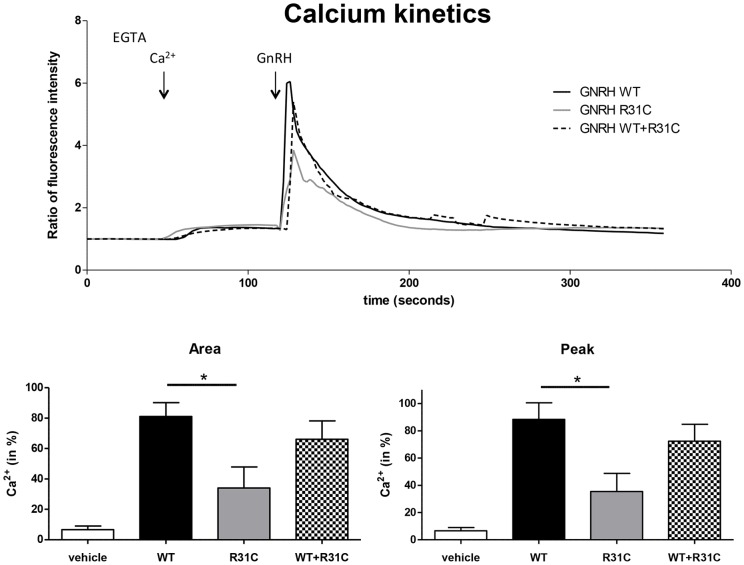
Effect of treatments on intracellular calcium mobilization.Cells were loaded with Fura 2-AM. At the time of the experiment 100 µM EGTA was added 30 sec before addition of 300 µM of CaCl2 (Ca2+) to the medium as indicated, and cells were then stimulated with 10 nM of wild type (WT), mutant (R31C) or equimolar combination (10 nM WT +10 nM R31C) or vehicle for 3 min. In the upper panel, representative curves of single cell recording. Each experiment mean was analysed using One-way ANOVA followed by Tukey's Multiple comparison test. In the lower panels, histograms show the means ± SEM (n = 4) of the response to ligands as calcium peak and as area under the curve (AUC). R31C-induced peak and AUC were significantly lower than WT. Combined treatment by WT+R31C did not induce a different calcium peak and AUC compared to WT alone. Representative of at least three independent experiments, *p<0.05.